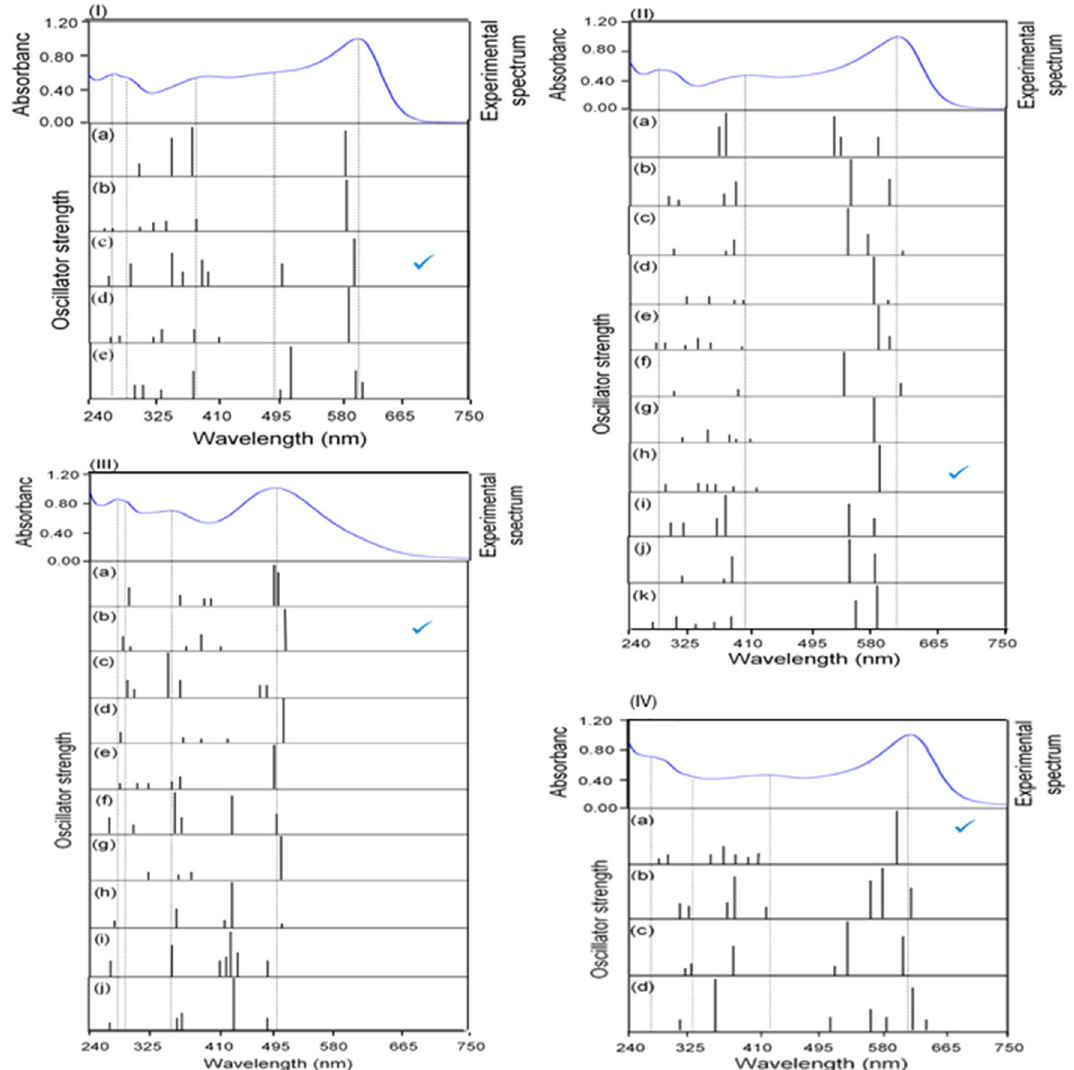
Figure 6. Computed wavelengths (black) and experimental spectrum (blue) for HMSs: (I) ( a ) 8-Oh(4), ( b ) 35-Oh(3), ( c ) 31-SP(1) , ( d ) 23-SP(1) and ( e ) 20-Td(1) of Zn II complexes, (II) computed wavelengths (black) and experimental spectrum (blue) for HMSs: ( a ) 8-Oh(4), ( b ) 21-Oh(1), ( c ) 27-Oh(4), ( d ) 37-Oh(3), ( e ) 38-Oh(3), ( f ) 40-Oh(2), ( g ) 16-SP(2), ( h) 28-SP(2) , ( i ) 37-SP(1), ( j ) 38-SP(1) and ( k ) 39-SP(1) of Cu II complexes, (III) computed wavelengths (black) and experimental spectrum (blue) for HMSs: ( a ) 14-Oh(4), ( b ) 15-Oh(4) , ( c ) 24-Oh(4), ( d ) 34-Oh(3), ( e ) 9-SP(2), ( f ) 12-SP(2), ( g ) 14-SP(2), ( h ) 31-SP(1), ( i ) 32-SP(1) and ( j ) 12-Td(2) of Fe II complexes and (IV) computed wavelengths (black) and experimental spectrum (blue) for HMSs: ( a ) Oh-13(4) , ( b ) Oh-16(3), ( c ) Oh-17(3) and ( d ) Oh-21(3) for the Fe II